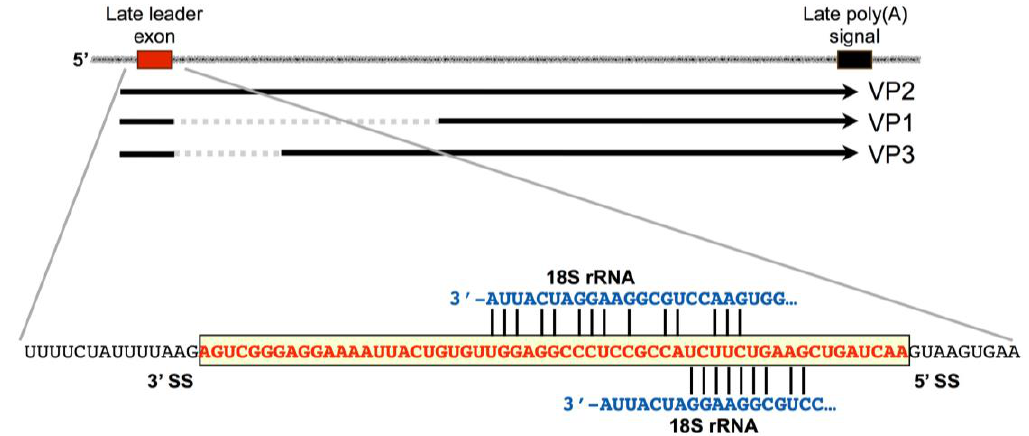
Figure 5. The late leader exon has regions of complementarity to 18S rRNA. While the biological consequence of this still remains unclear, there is striking complementarity to ribosomal RNA at two positions within the leader. We speculate that in late mRNAs containing tandem leaders in their 5′-untranslated regions (UTRs), these elements may serve to enhance the translation of late proteins.